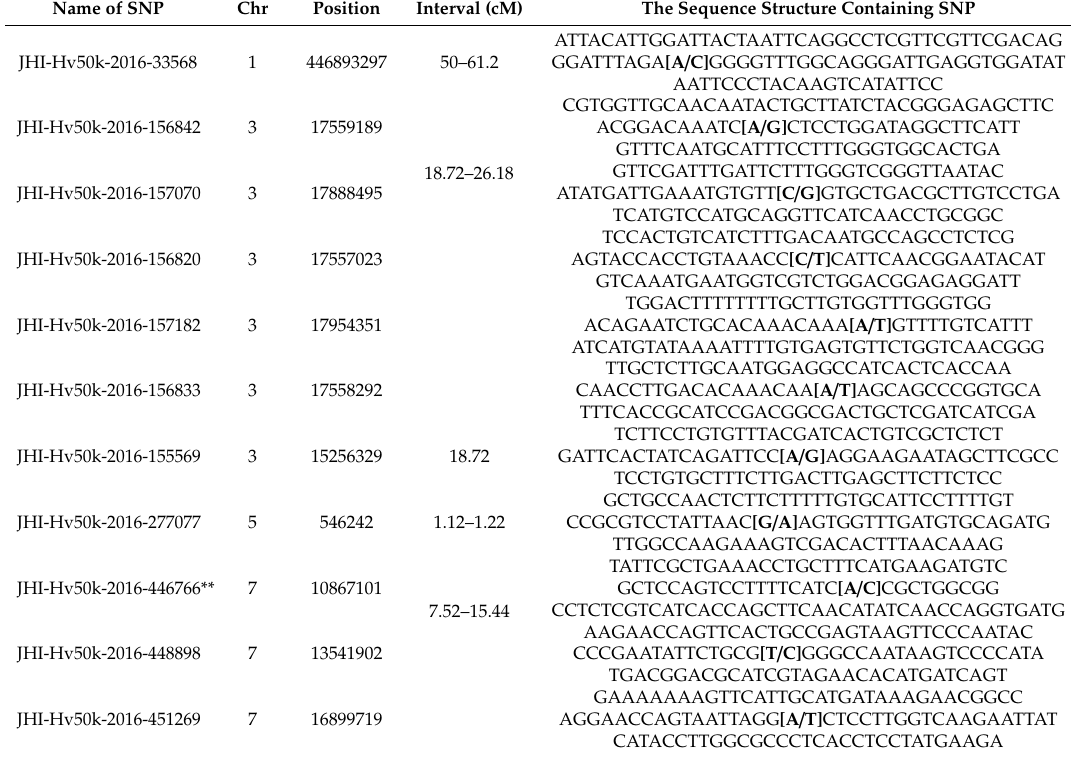
Table 3. KASP markers.